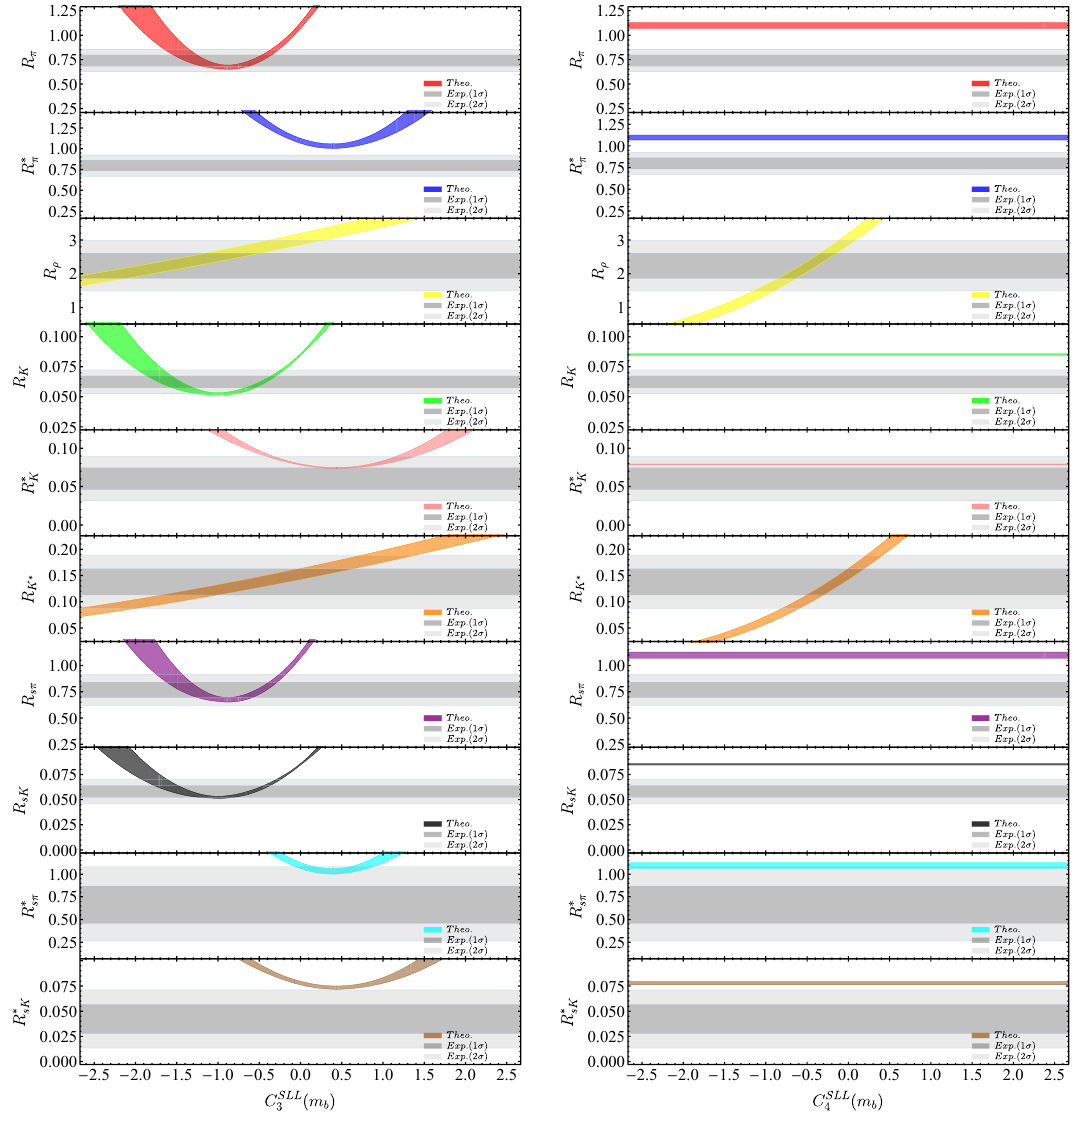
Figure 8 . Same as in figure 5 but for the NP Wilson coefficients C SLL